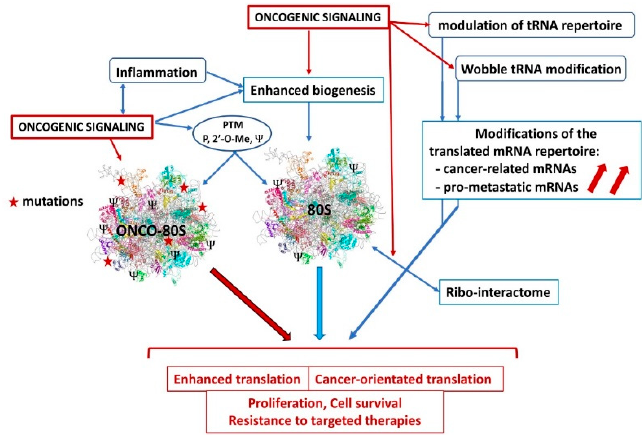
Figure 2. Dysregulations affecting ribosome functions in cancer. Oncogenic signaling and chronic inflammation can stimulate ribosome biogenesis and/or alter post-translational modifications, to stimulate translation efficiency or specificity. The supposed 80S oncoribosome could bear mutations, display differential expression of some critical RPs for enhanced activity or difference in the translated mRNA repertoire, favoring cancer cell metabolism. Oncogenic signaling could modulate the tRNA repertoire and the translation selectivity (Wobble effect) to favor expression of cancer and pro-metastatic mRNAs. Modifications of the ribo-interactome by oncogenic influences could favor the translation of a cancer-related mRNA repertoire. PTM: post-translational modification, P: phosphorylation, 2 ′ -O-Me: methylation, Ψ : pseudouridination.